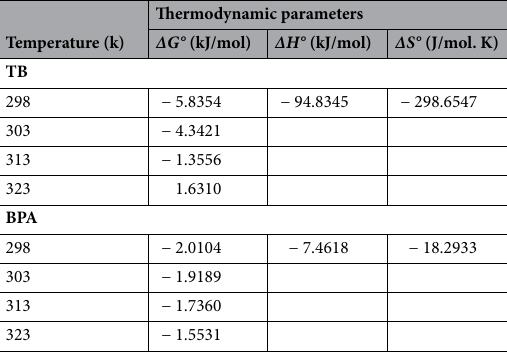
Table 4. Thermodynamic parameters for TB and BPA adsorption on FGS2